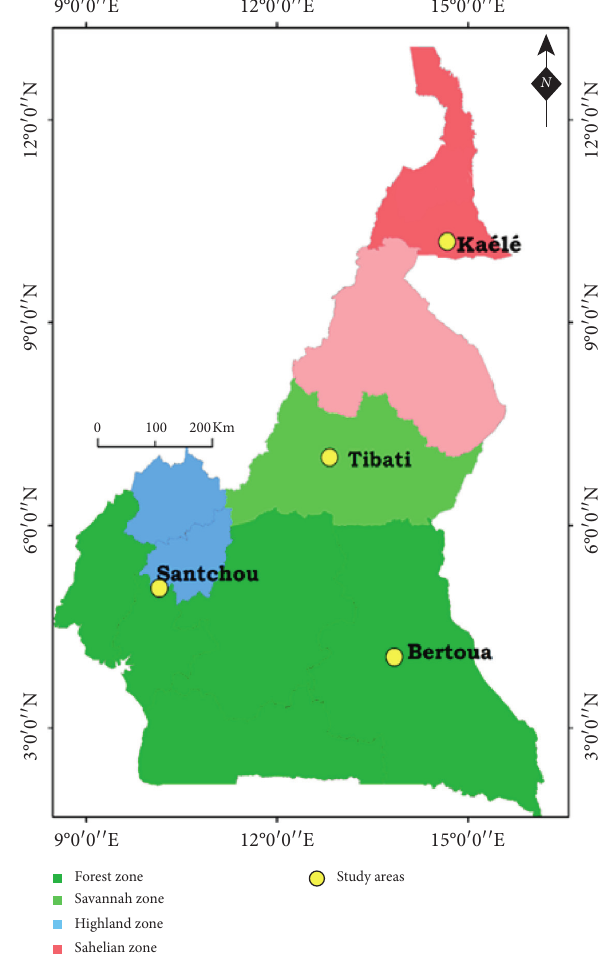
Figure 1: Map of the study area,